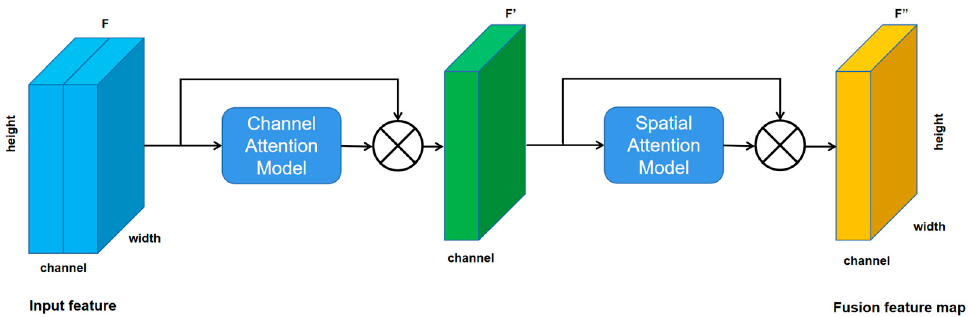
Figure 8. Structure illustration of the channel and spatial attention